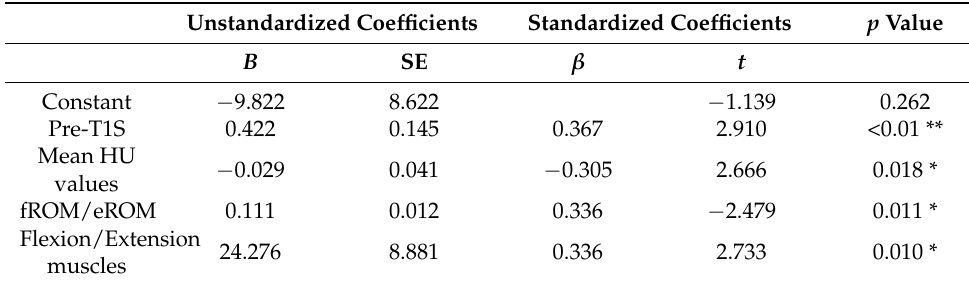
Table 5. Association between various factors and LCL in multiple linear regression